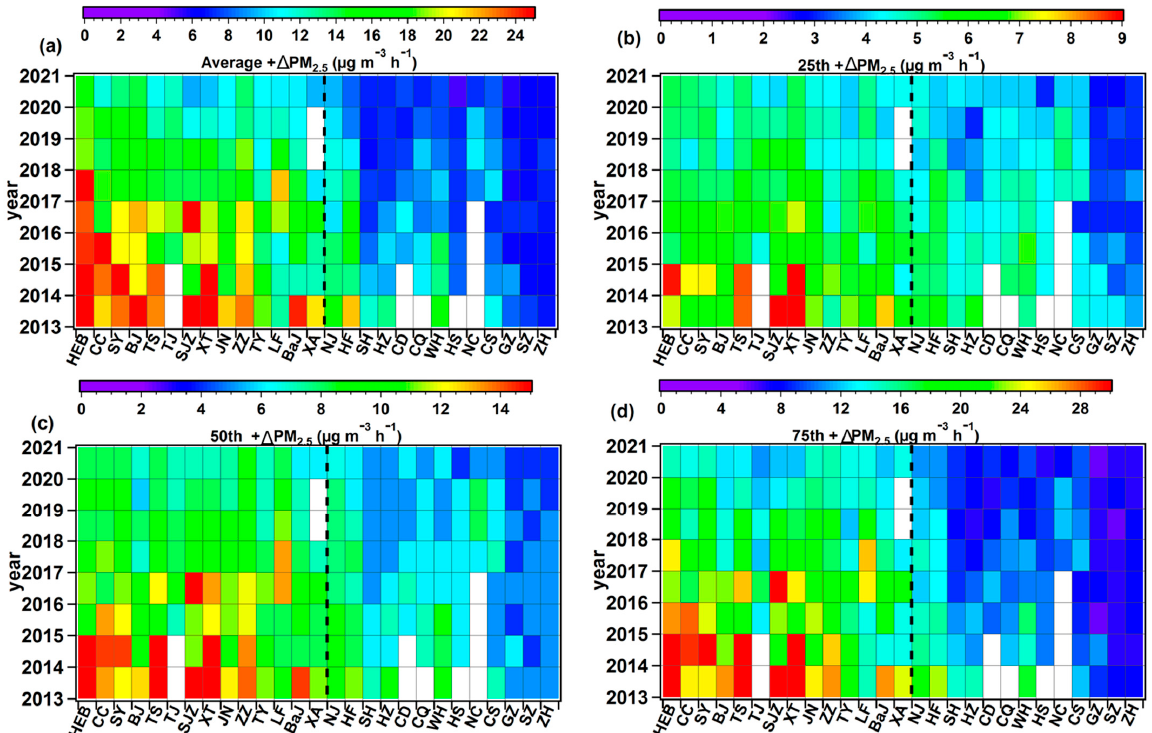
Figure 3. Statistical graph of annual average ( a ), 25th ( b ), 50th ( c ), and 75th ( d ) percentile value of + ∆ PM 2.5 in representative stations of each region in central and eastern China from 2013 to 2020 in autumn and winter.